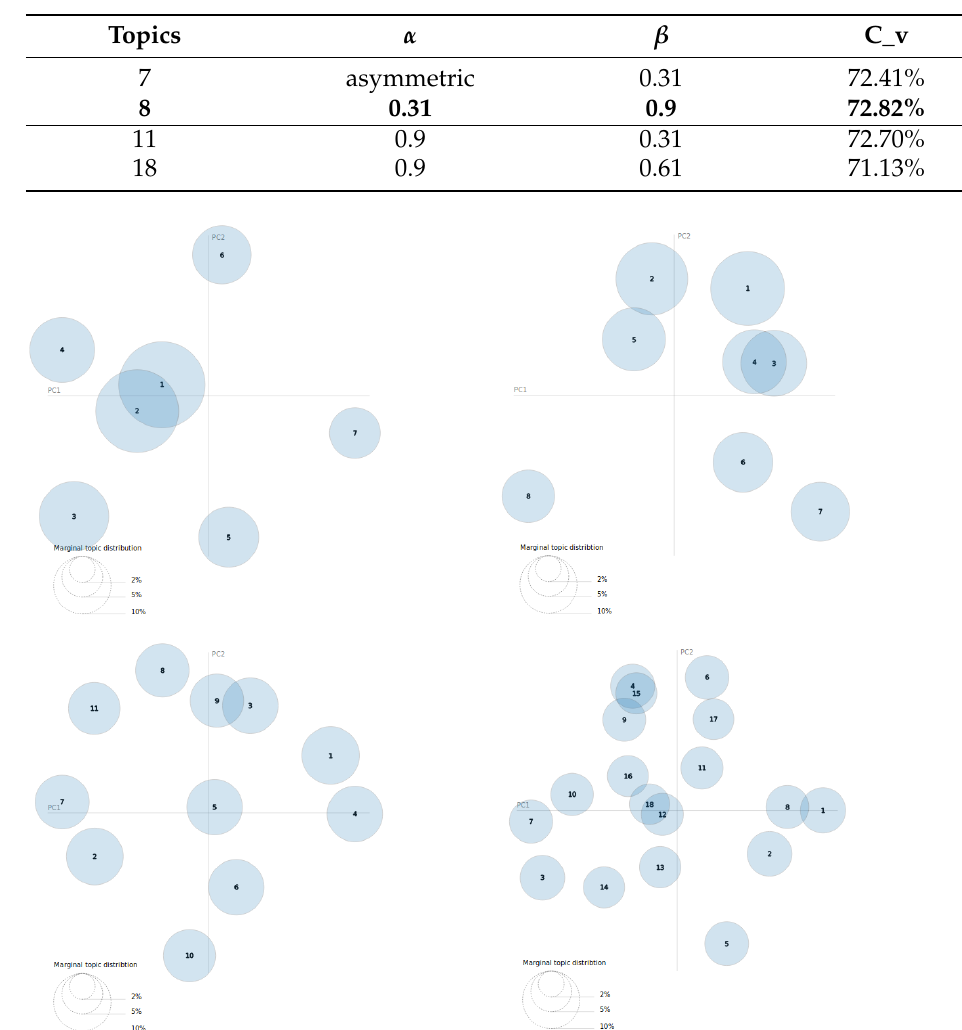
Table 2. Optimizing LDA Hyperparameters.